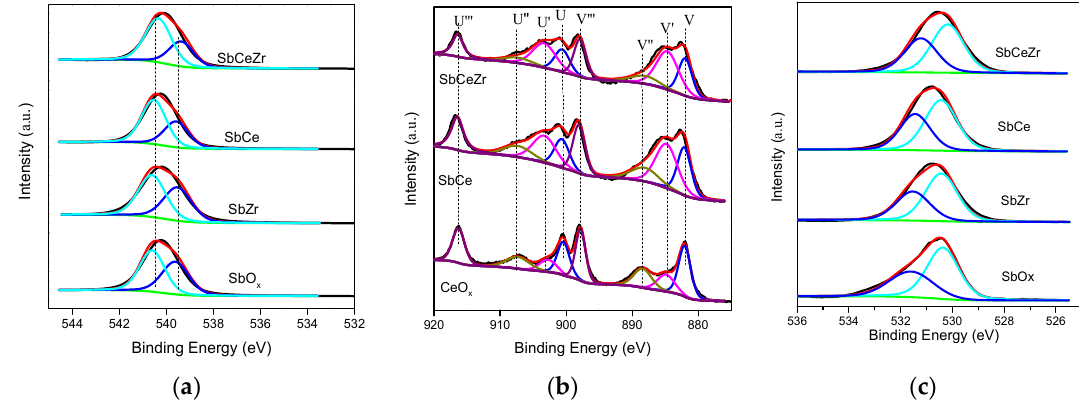
Figure 4. XPS spectra for ( a ) Sb3d, ( b ) Ce3d, and ( c ) O1s over the catalysts.